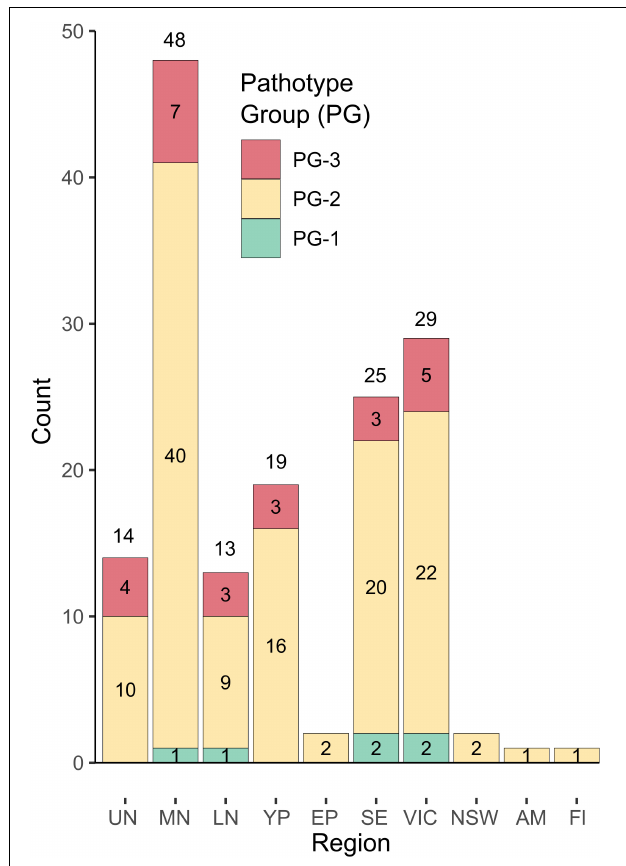
FIGURE 3 | Distribution of pathogenicity groups in geographic regions for isolates collected from 2015 to 2018. Isolates were classified as pathogenicity group (PG), PG-1, PG-2, or PG-3 based on the differential host cultivar reaction. Region abbreviations are as follows: Upper North SA, UN; Mid North SA, MN; Lower North SA, LN; Yorke Peninsula SA, YP; Eyre Peninsula SA, EP; South-East SA, SE; Victoria, VIC, and New South Wales, NSW, and single isolates from an Adelaide Metropolitan site (AM) and a location on the Fleurieu Peninsula (Fl) south of Adelaide were also included.